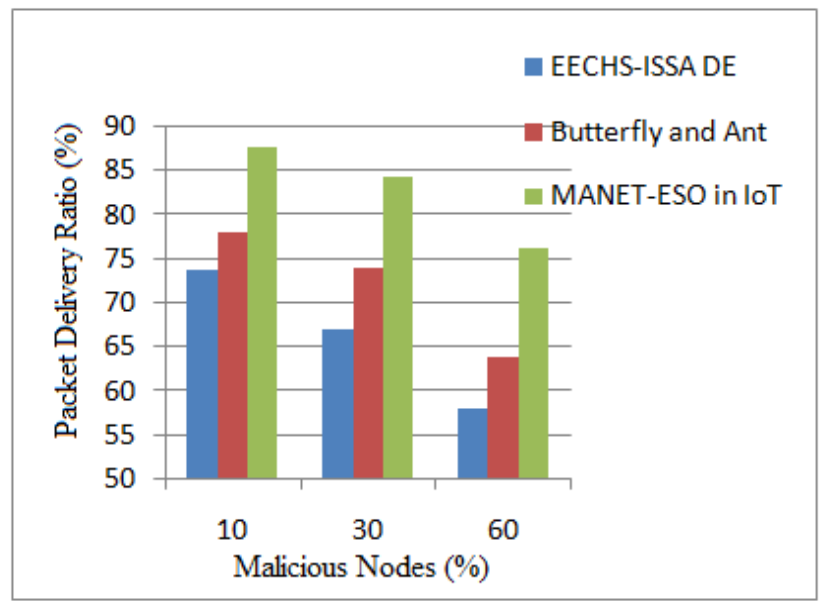
Figure 7. Packet Delivery Ratio vs. Malicious Nodes